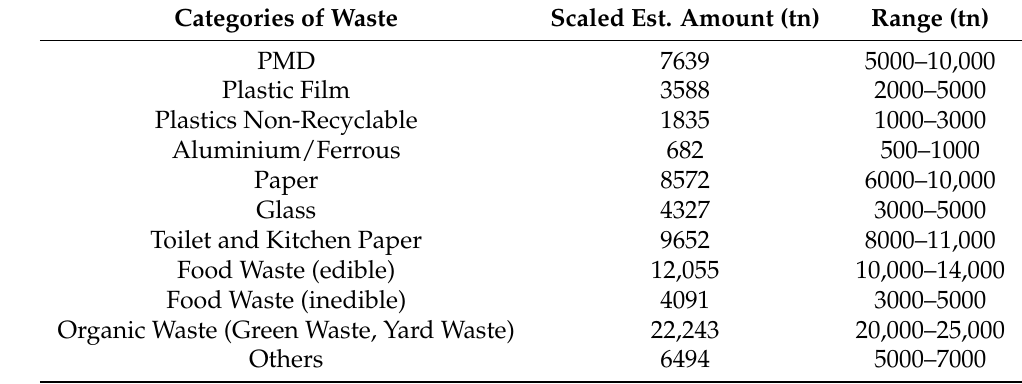
Table 15. Waste Compositional Analysis categories for a population of 100,000 people and possible range in tn for each of the categories (figures per [13]). This table is used only for designing purposes and its amounts were later scaled to express the upper and lower bounds of each of the area population